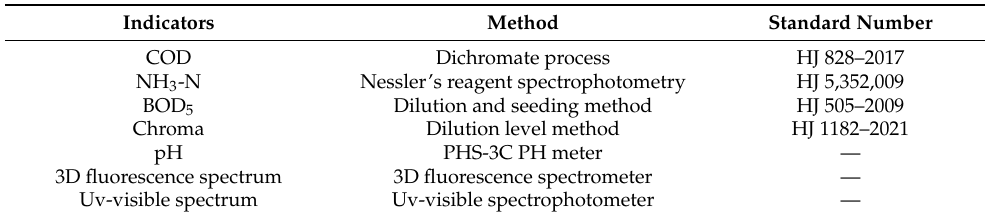
Table 3. Detection